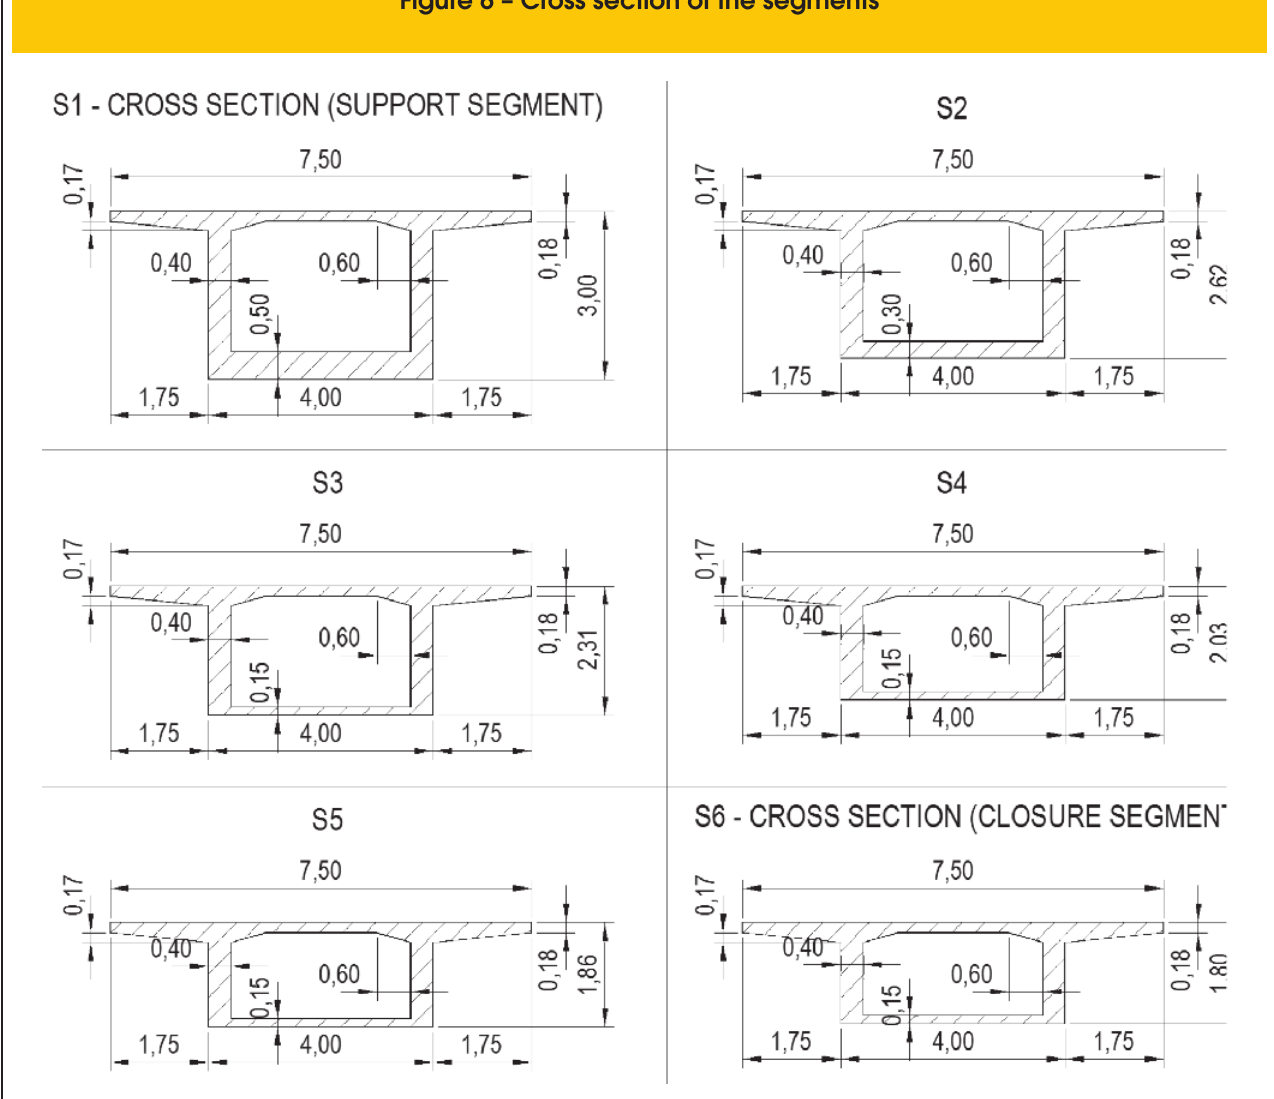
Figure 6 – Cross section of the